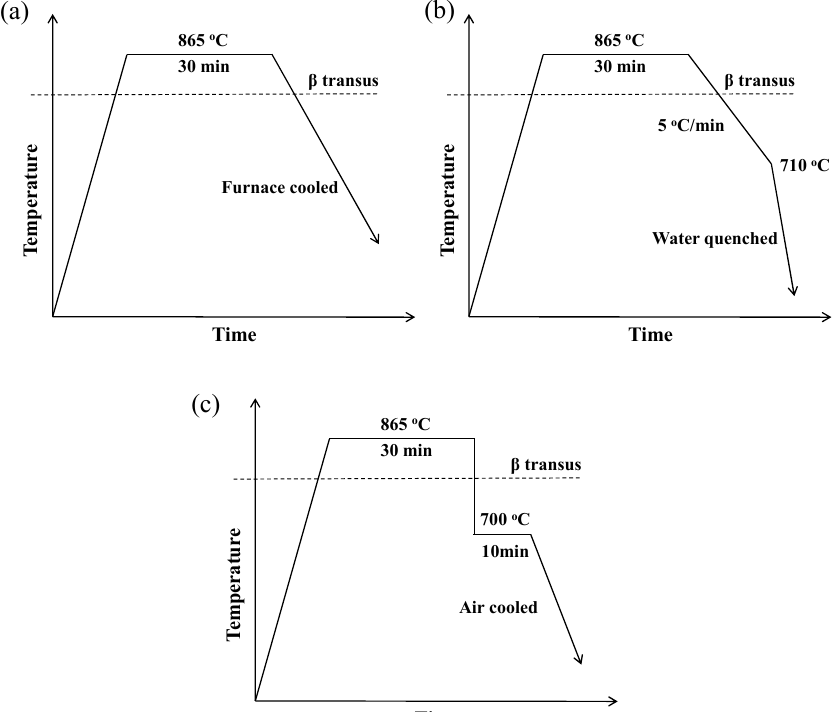
Figure 3. The schematic diagram of heat treatment scheme of: ( a ) furnace cooling without specific control; ( b ) continuous cooling process; ( c ) isothermal heat treatment.